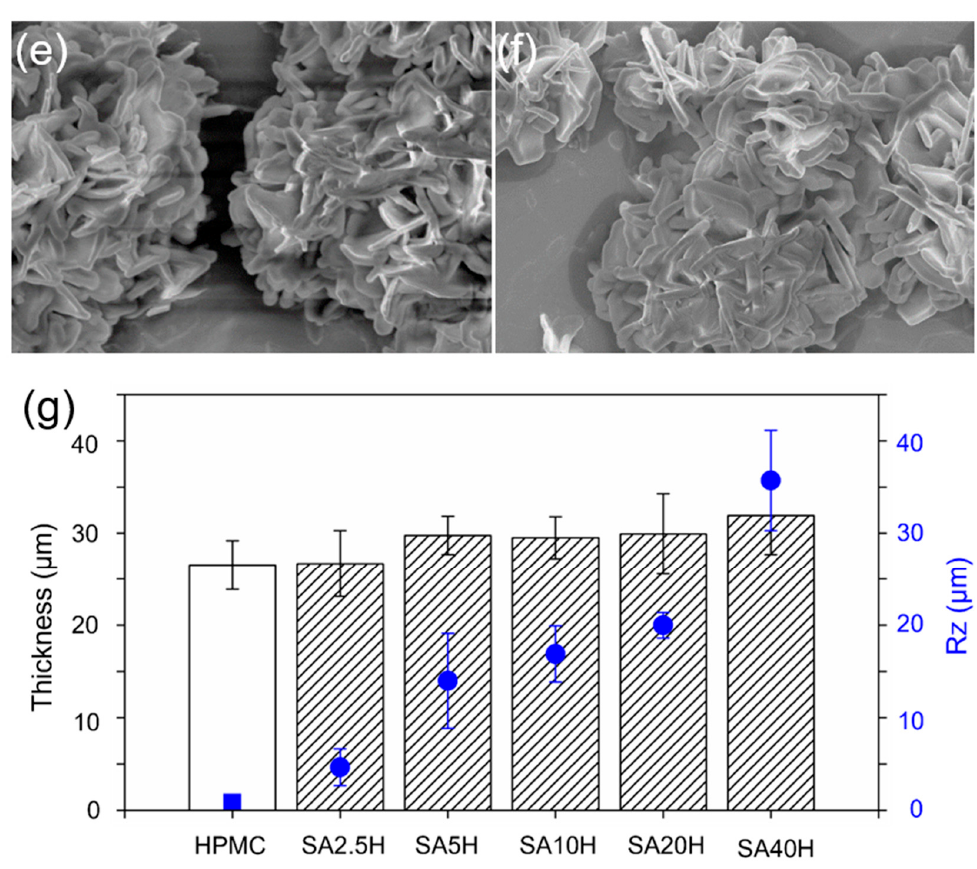
Figure 1. Surface morphology of ( a ) pure HPMC, ( b ) SA2.5H, ( c ) SA5H, ( d ) SA10H, ( e ) SA20H, ( f ) SA40H, and ( g ) film thickness and surface roughness (Rz) of composites.